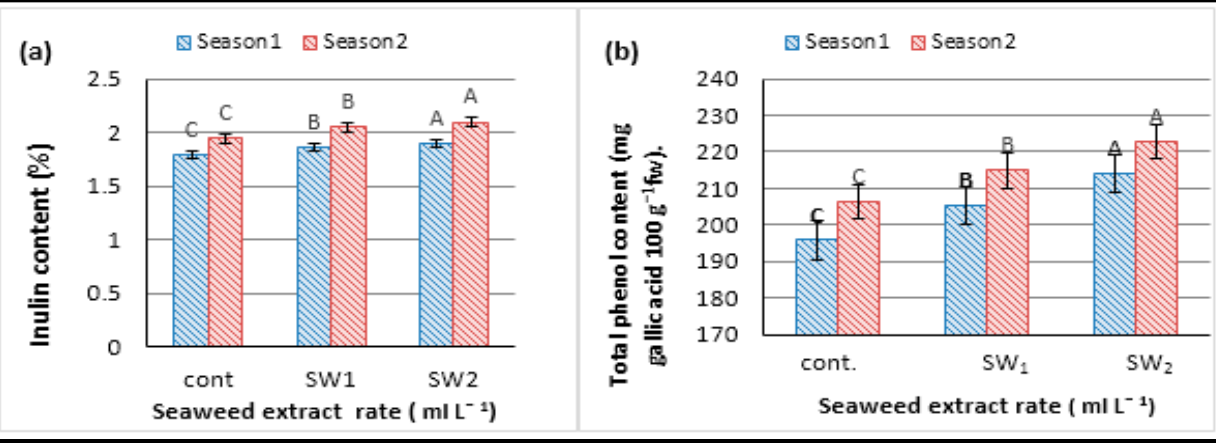
Figure 9. Head quality (mean ± SE) of globe artichoke as affected by the seaweed extract rate (Control: without, SW 1 : 5 and SW 2 : 10 mL L − 1 ) on ( a ) Inulin (%) and ( b ) Total phenols (mg gallic acid 100 g − 1 fw). Letters in the figures indicate that the mean ± SE treatments with the same letters were not significantly different according to Duncan’s multiple range test for p < 0.05.